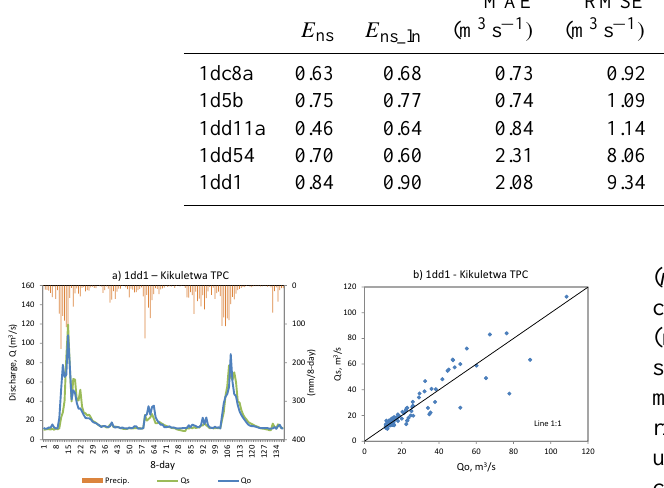
Table 1. Model performance for the modified STREAM model for upper Pangani River basin. Station Calibration Validation MAE RMSE MAE